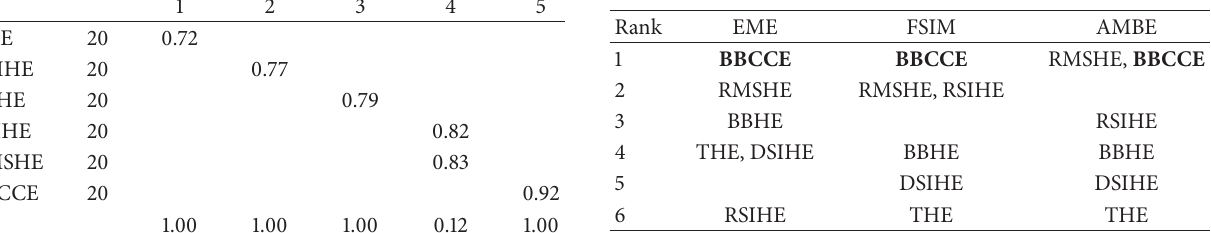
Table 9: Ranking of methods in terms of enhancement degree (EME), image quality (FSIM), and mean intensity distortion (AMBE). The methods ranking is computed according to Fisher’s Least Significance Difference (LSD) and the Duncan